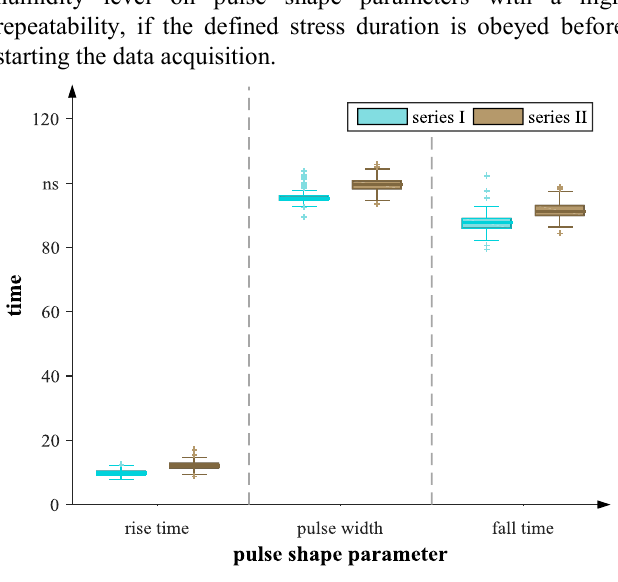
Fig. 5. Box plots for the pulse shape parameters rise time, pulse width and fall time of two different measurement series carried out at a temperature level of 20 °C and a absolute humidity level of 11 g/m³.